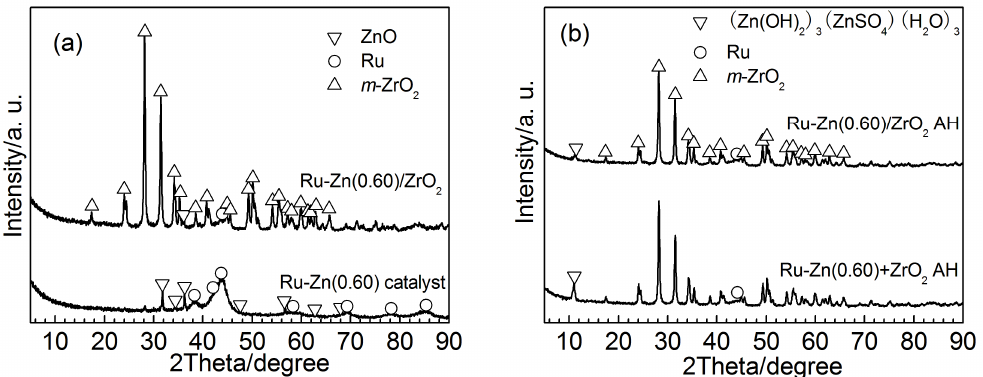
Figure 8. XRD patterns of the supported Ru-Zn(0.60)/m-ZrO 2 catalyst and the unsupported Ru-Zn (0.60) catalyst before ( a ) and after ( b ) catalytic experiments.